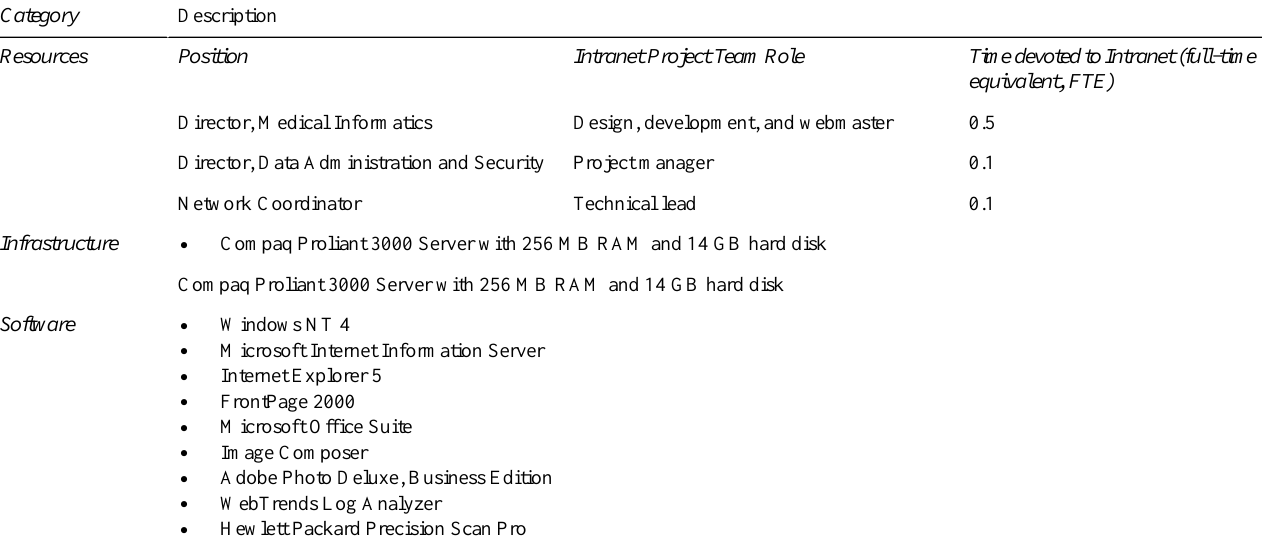
Table 1. Intranet Resources, Infrastructure, and Software Description